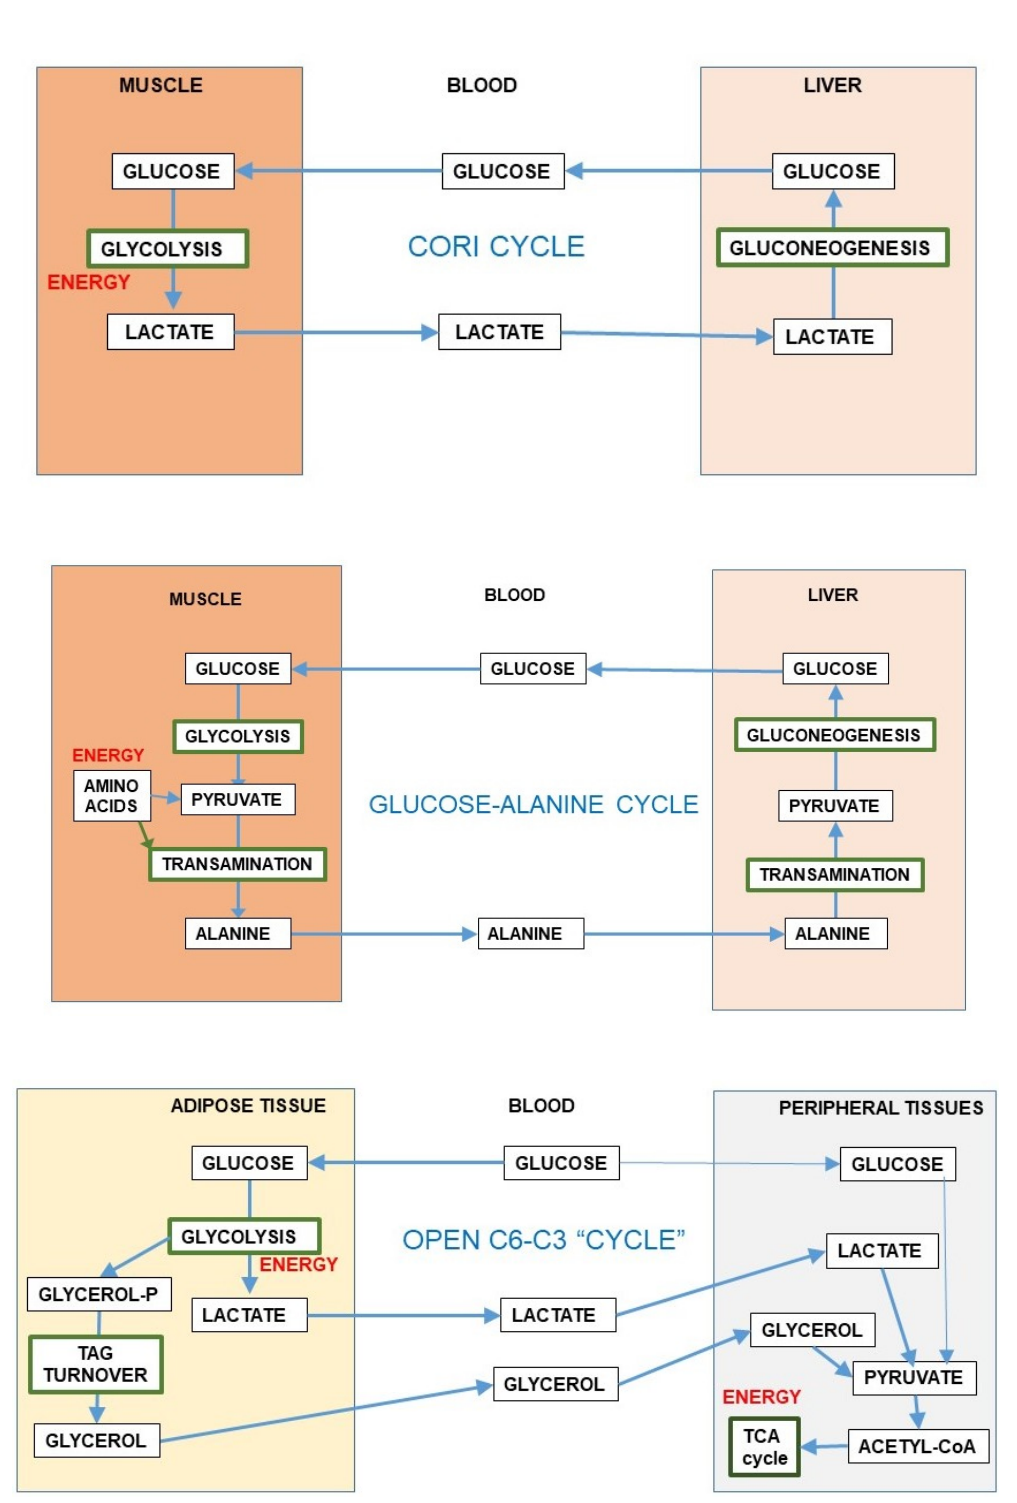
Figure 5. Inter-organ substrate cycles (6C-3C). The first and second panels present the Cori cycle and glucose-alanine cycle [89]. The lower panel shows an “open” inter-organ relationship (6C-3C) such as that found between the adipose tissue and peripheral organs [49].